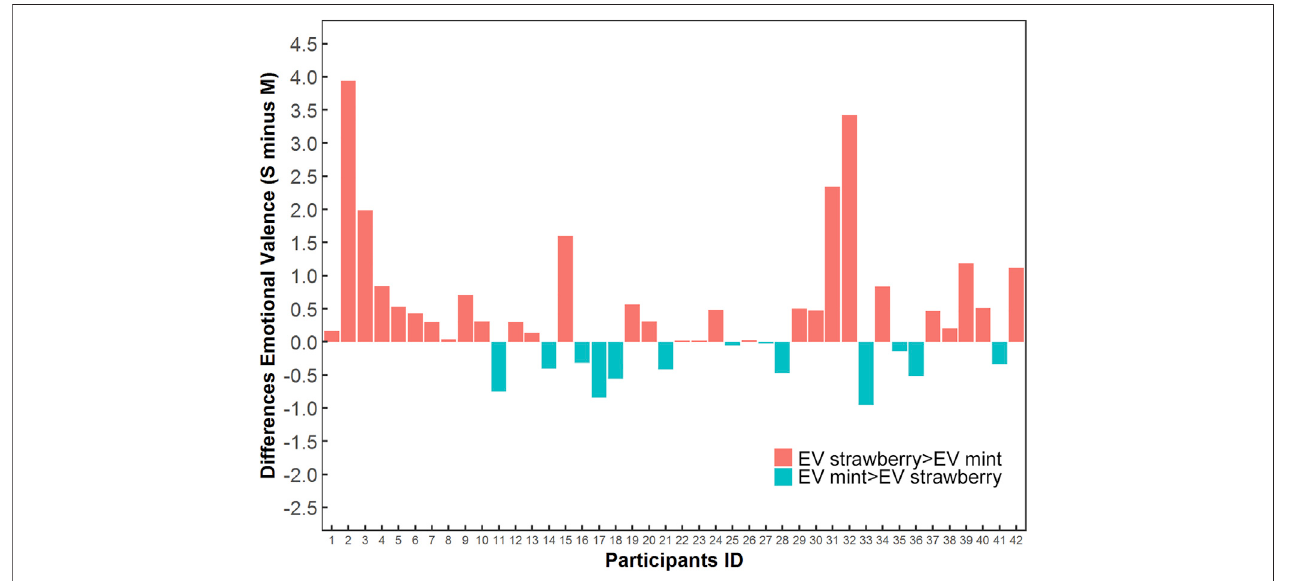
FIGURE 3 | The distributions and differences of the emotional valence for child participants taking carbocysteine preparations.